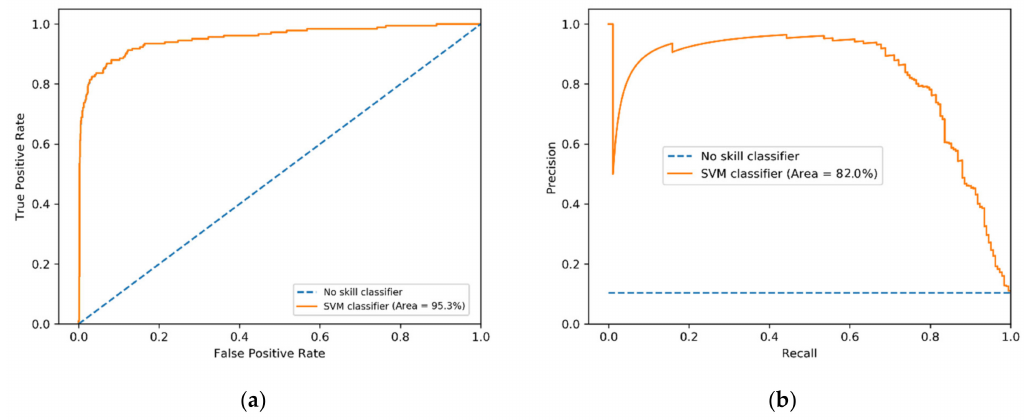
Figure 1. Examples of the Receiver Operating Characteristic (ROC) and Precision–Recall (PR) curves for an Support Vector Machine (SVM) applied to the same imbalanced dataset; ( a ) The ROC curve (AUC = 95.34) ( b ) The PR curve (AUC =